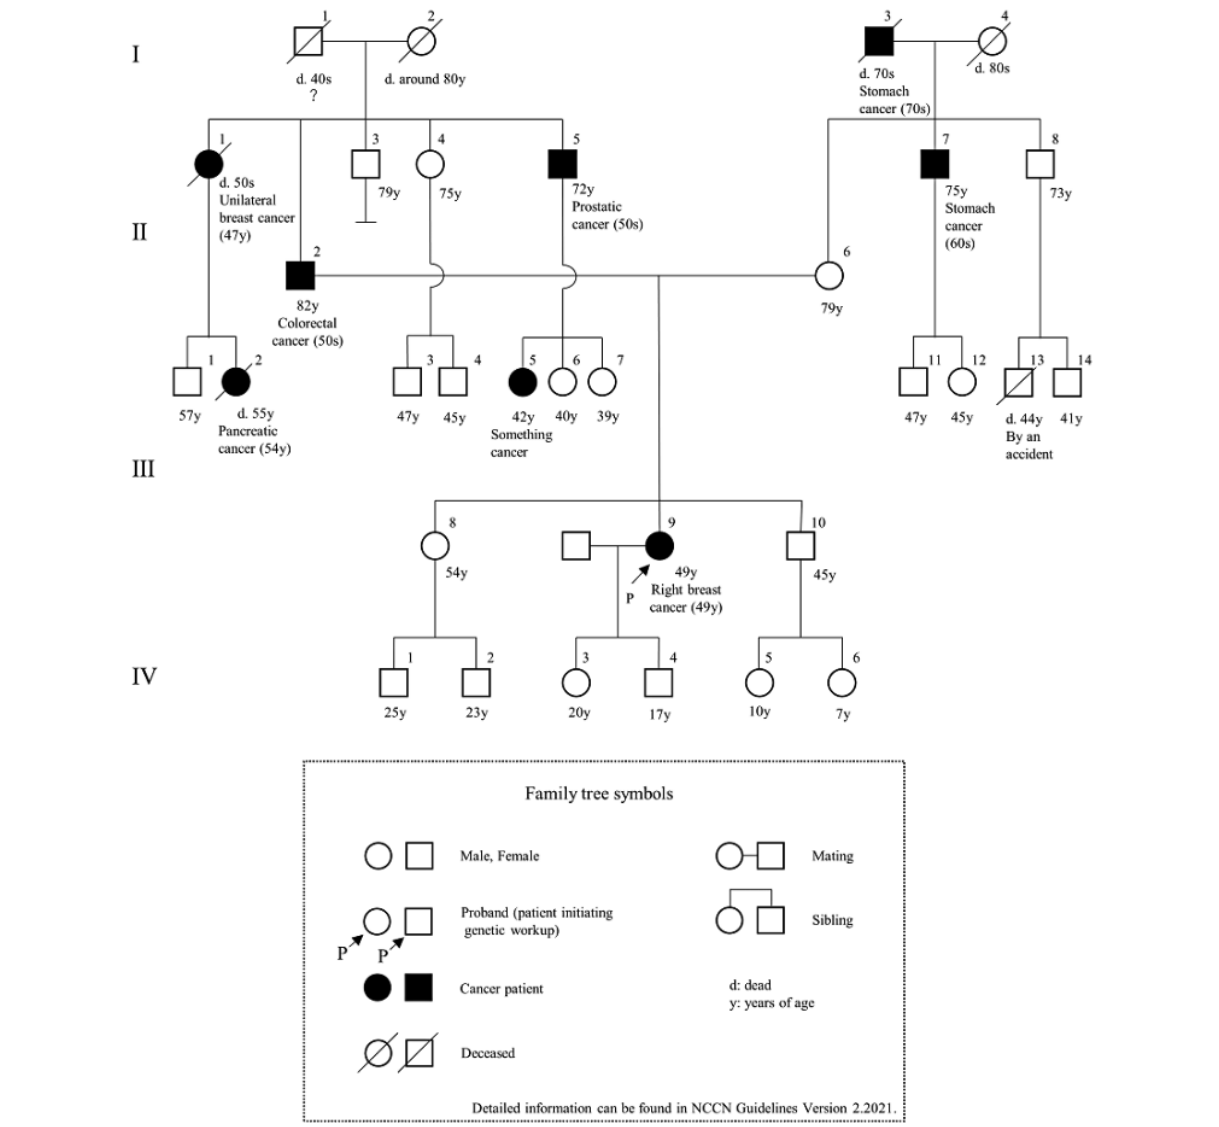
Figure 2. The family tree in scenario